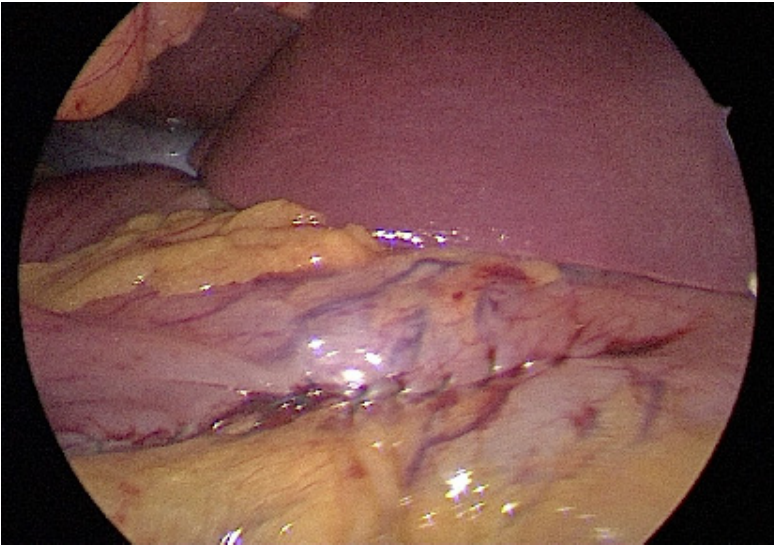
Figure 3. Laparoscopic reinforced suturing over the stapling line after closure of the perforation site at the anterior antrum.